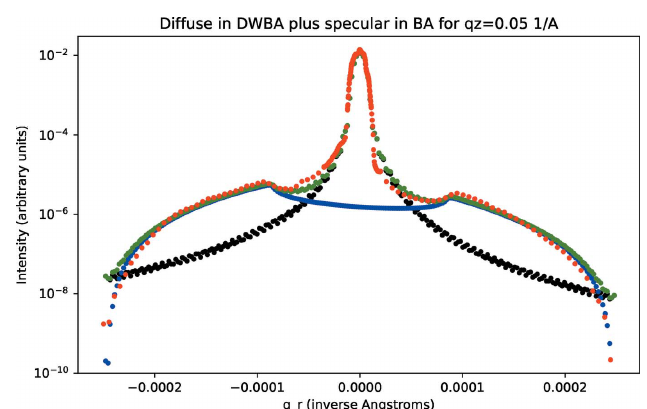
Figure 7 Smooth sample: rocking data and calculated fit (green) for q z = 0.05 A˚ (cid:2) 1 ; measured data (red), calculated specular scattering in the BA (black), calculated diffuse in the DWBA (blue), and total calculated scattering (green).